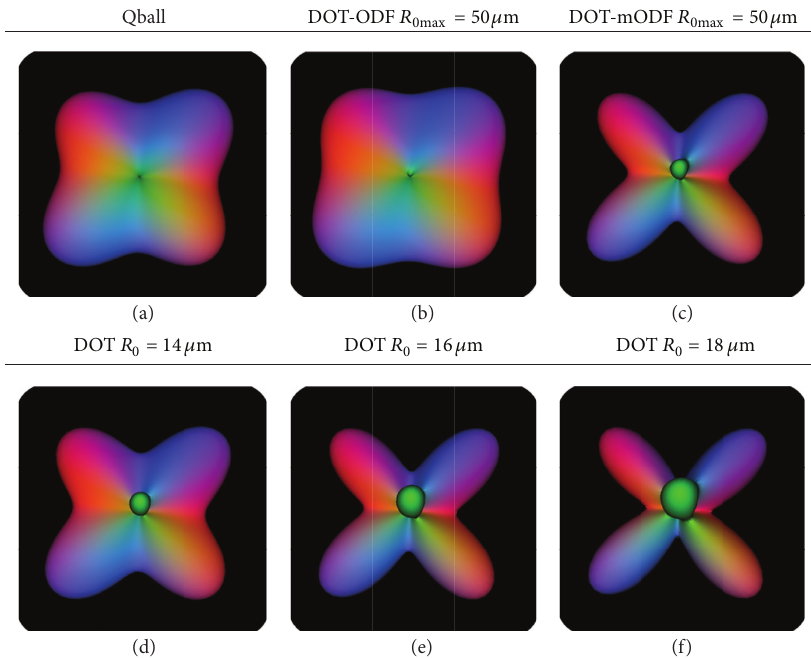
Figure 1: Profiles of the DOT and the proposed derivations in a single crossing voxel from a real brain in the area of the centrum semiovale. The data is acquired at b = 1500 s / mm 2 and 60 gradient directions. For the DOT, the effective diffusion time t is set to 25 ms. We observe that the DOT-mODF performs similarly as the DOT reconstructed at R 0 = 16 𝜇 m. Additionally, Q-ball and the DOT-ODF show similar diffusion